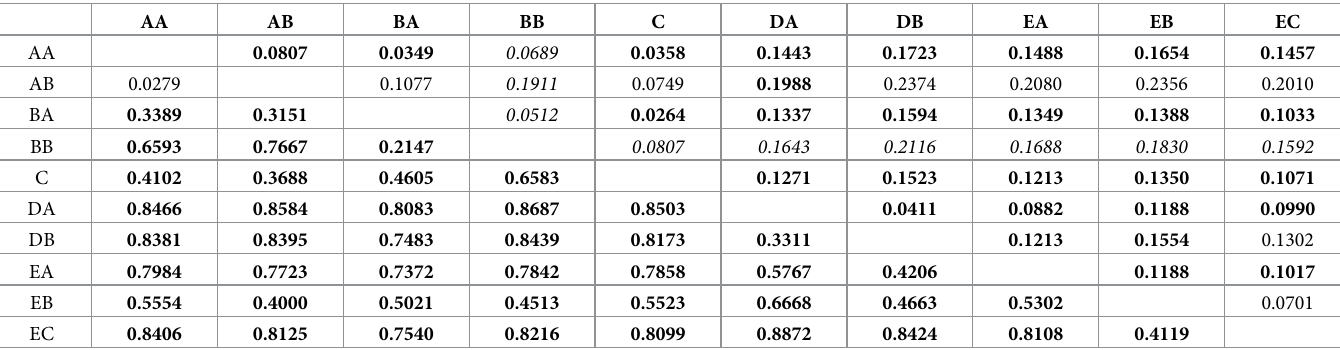
0.7540 Values significantly different from zero (at alpha < 0.05) are indicated in bold. The significance of some F ST values could not be determined because of low genetic variability in region BB, indicated with